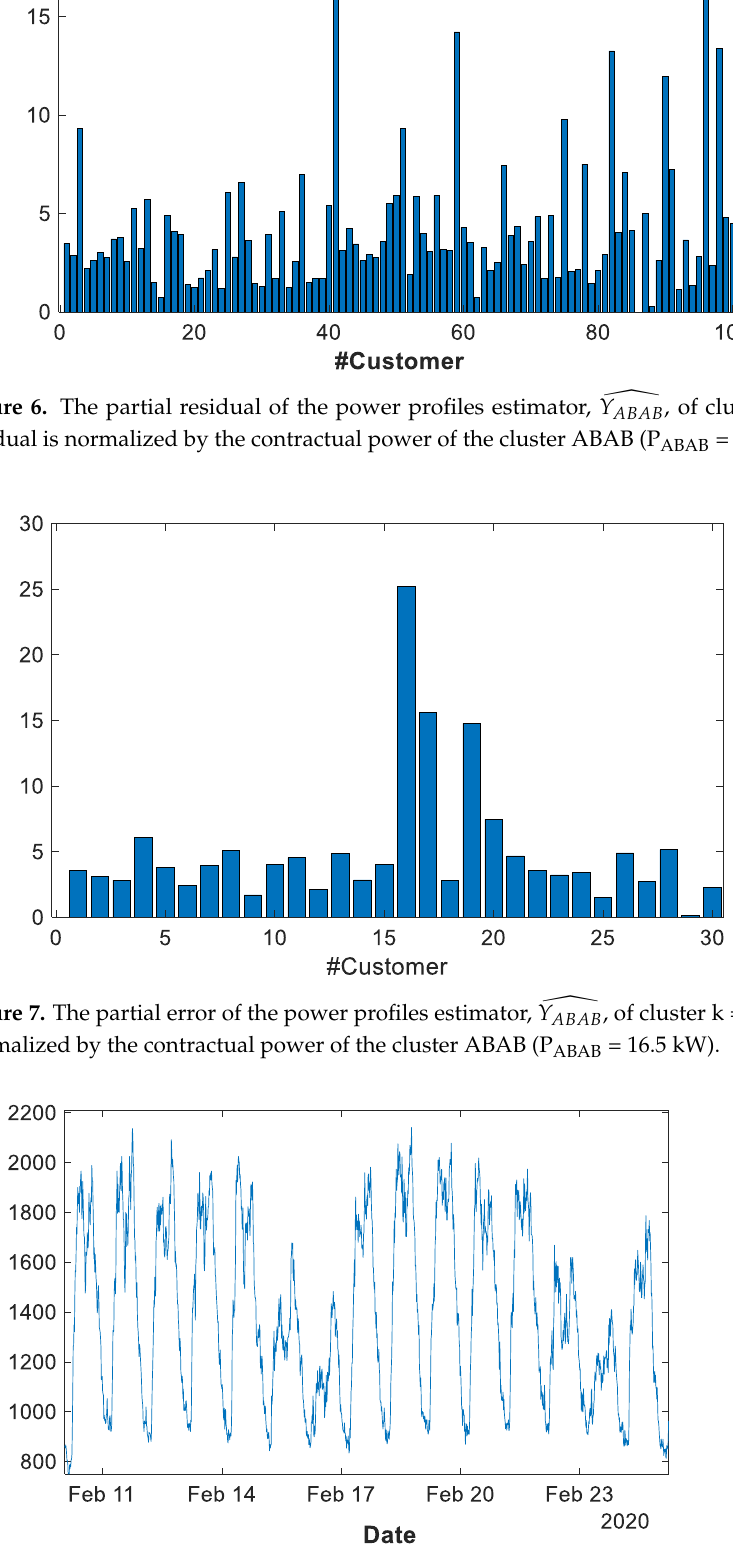
Figure 8. The power profile estimator, 𝑌 𝑘 ̂ , of cluster ABAB during 11 – 25 February